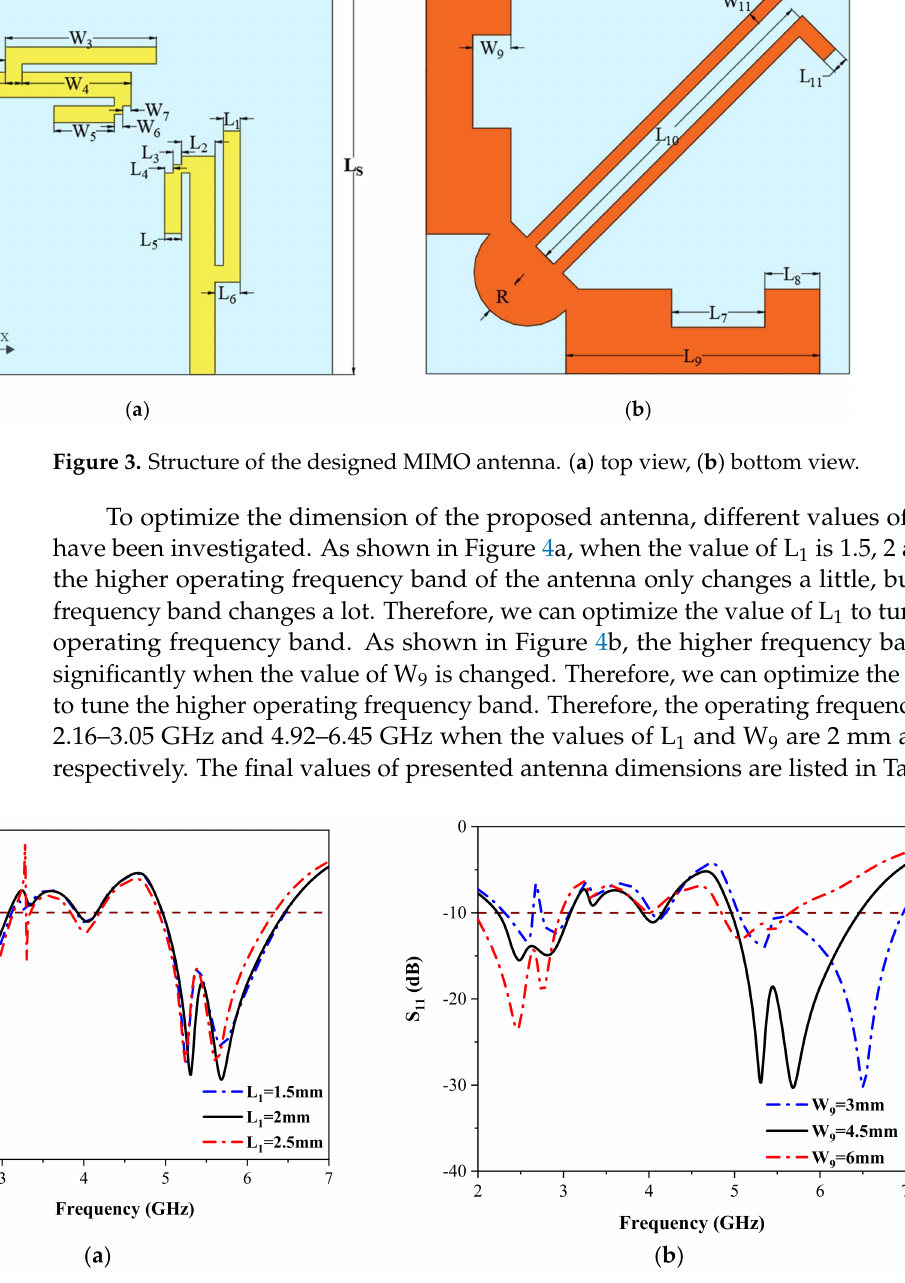
Figure 4. The simulated S parameters at different values of ( a ) L 1 and ( b ) W 9